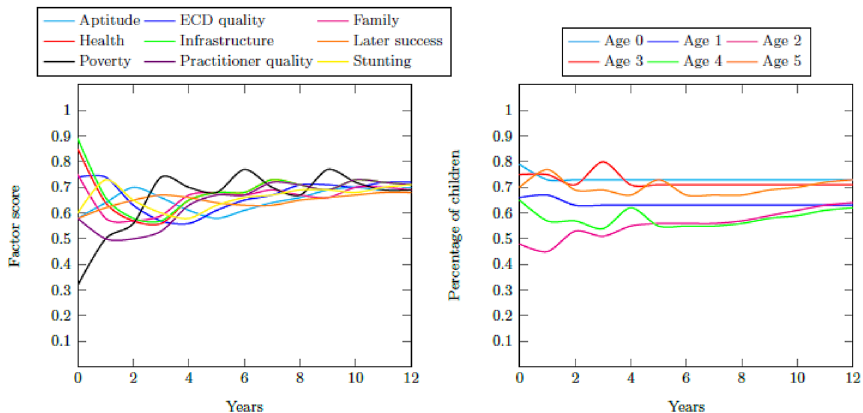
Fig. 15 Factor scores for the decreased poverty intervention and the percentage of children with adequate development for their age for Quintiles 1–3 for the increased enrolment